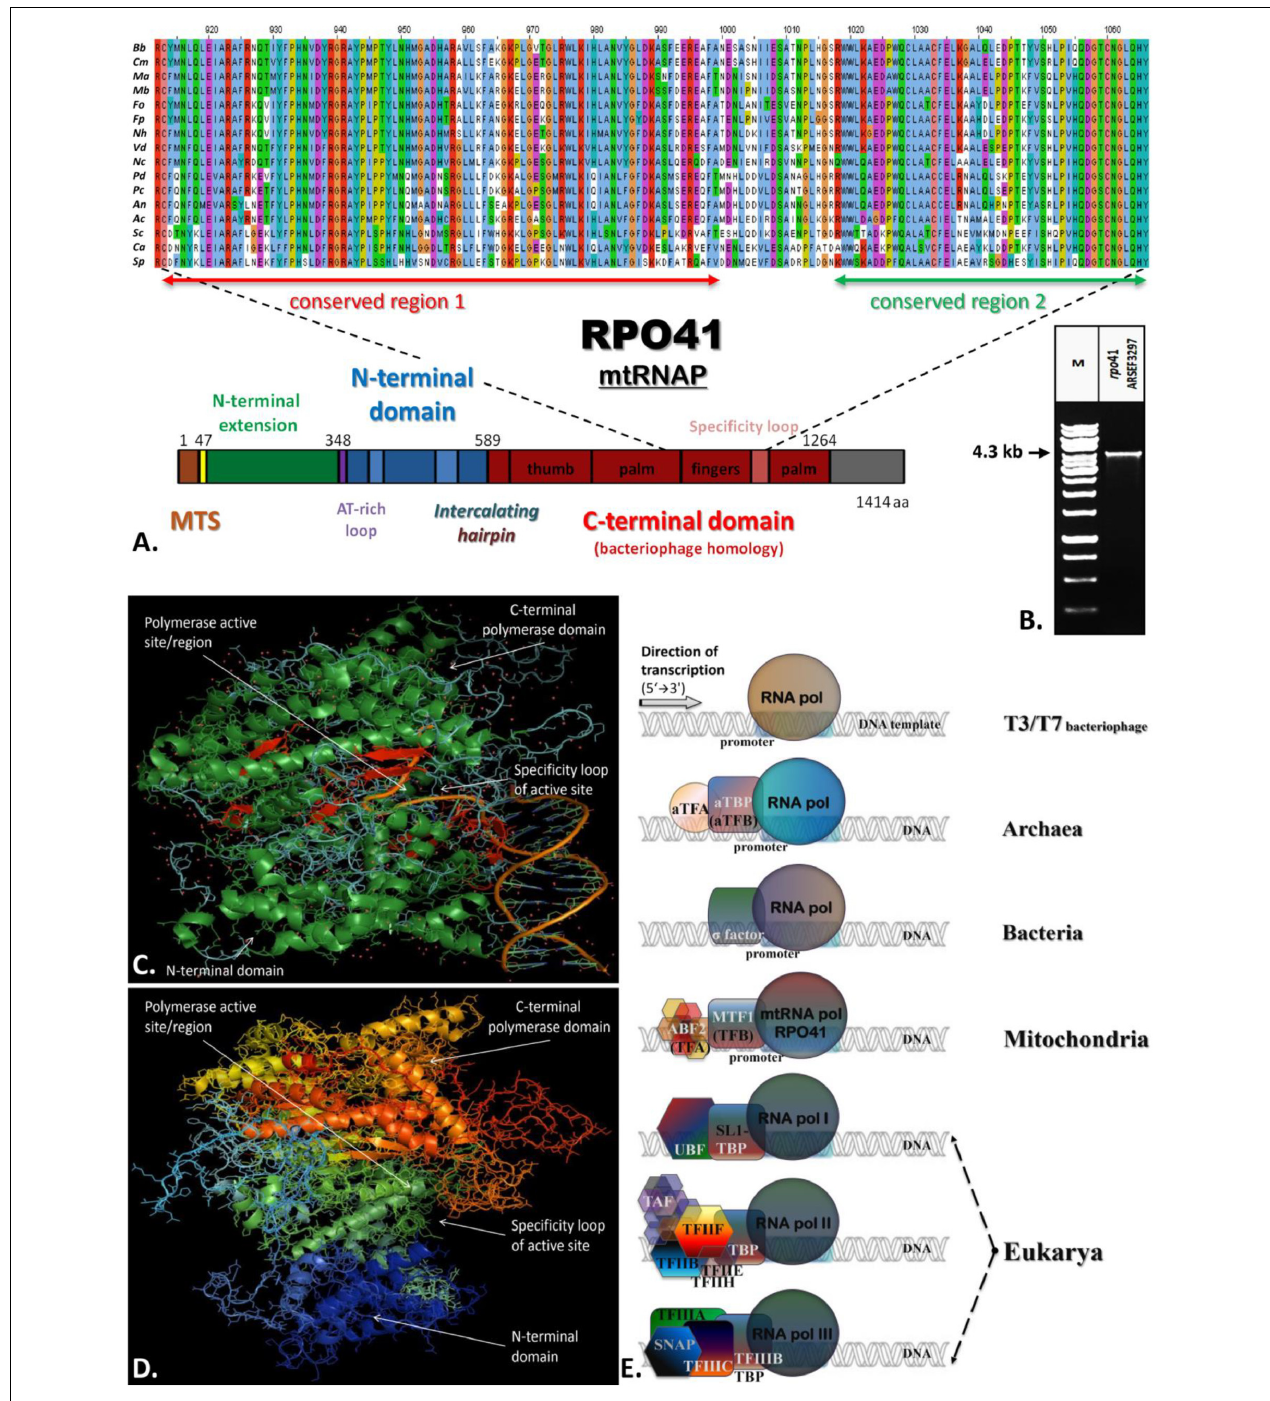
FIGURE 5 | The structure of Rpo41 from M. brunneum ARSEF 3297. (A) Multiple sequence alignment of Rpo41 from selected Ascomycetes ( Bb, Beauveria bassiana; Cm, Cordyceps militaris; Ma, Metarhizium acridium; Mb, Metarhizium brunneum; Fo, Fusarium oxysporum; Fp, Fusarium pseudograminearum; Nh, Nectria haematococca; Vd, Verticillium dahlia; Nc, Neurospora crassa; Pd, Penicillium digitatum; Pc, Penicillium chrysogenum; An, Aspergilus nidulans; Ac, Ajellomyces capsulatum; Sc, Saccharomyces cerevisiae; Ca, Candida albicans; Sp., Schizosaccharomyces pombe ), for determining conserved regions—domains, using ClustalX. (B) The amplified whole gene rpo 41 of M. brunneum ARSEEF 3297. (C) Crystallographic structure of RNA polymerase is bacteriophage T7 (PDB_ 1QLN). Green represented alpha-helices, while red beta-sheets. The random coil structures are displayed in cyan. The greater part of the protein structure consists of a-helices. (D) Prediction of the structure of mt-RNA polymerase (Rpo41p) of M. brunneum ARSEF 3297. All structures were constructed using the softwares PSIPRED, HHpred and PyMol. (E) A comparative schematic representation of all RNA polymerases and their transcriptional factors as described for T3/T7 phages, archaea, bacteria, mitochondria, and nucleus of eukaryotes (based on information provided by Werner, 2007, 2012, Werner and Grohmann, 2011).